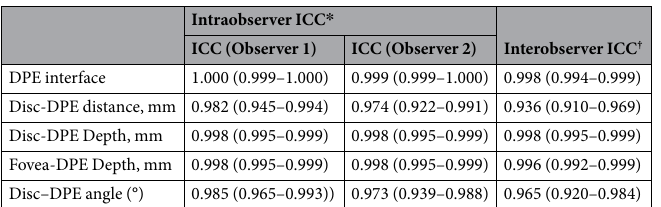
eyes and the myopic eyes. While the location of the DPE in the emmetropic group had majority near the disc (47.5%) followed by fovea, inferior and superior (22.5%, 22.5% and 7.5%, respectively), the myopic group had significantly larger in the myopic eyes than the emmetropic eyes (3661.5 ± 1308.5 vs. 2667.5 ± 1103.5 μ m, respec- (128.8 ± 170.1 vs. 35.9 ± 84.4 μ m, respectively; P = 0.001). On the other hand, the Fovea-DPE distance was signif- statistical difference (176.4 ± 172.4 vs. 355.3 ± 109.2 μ m, respectively; P = 0.473). There was significantly larger